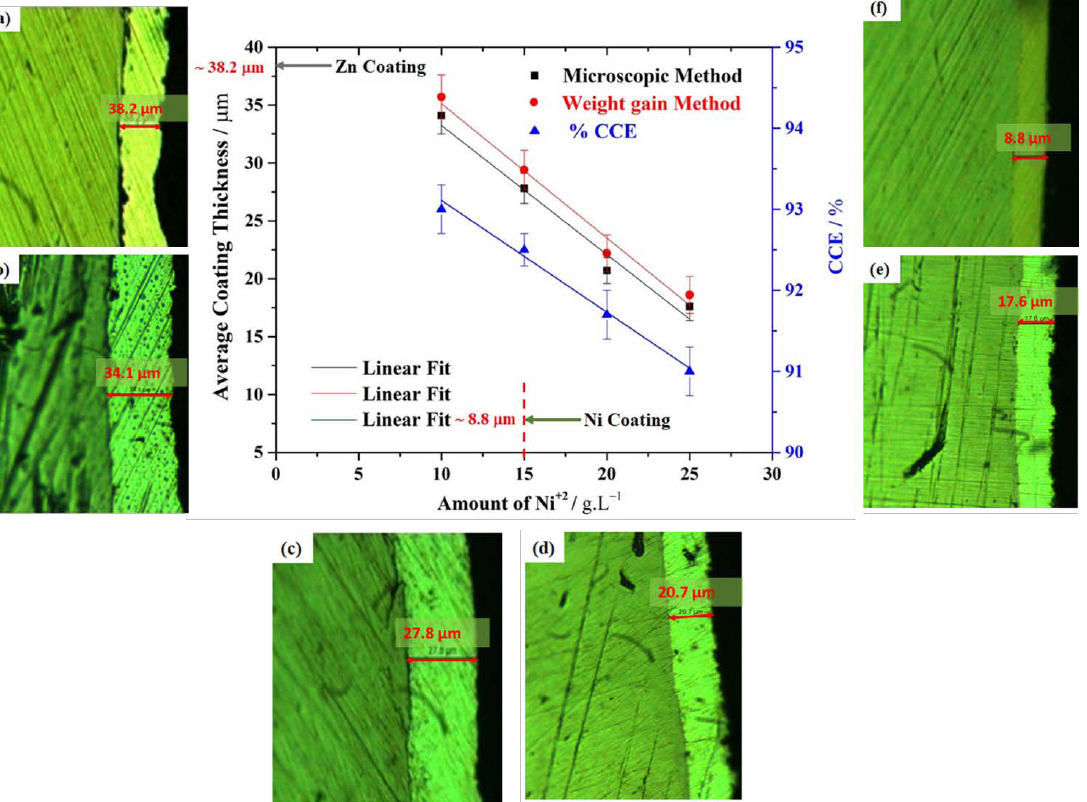
Figure 2. Cross-sectional microstructural of the ( a ) pure Zn, ( b ) Zn-Ni-10, ( c ) Zn-Ni-15 ( d ) Zn-Ni-20, ( e ) Zn-Ni-25, and ( f ) pure Ni coatings. Quantitatively, the central figure describes the variation in coating thickness and % cathodic current efficiency (CCE) as a function of Ni concentration in the electroplating bath solution .